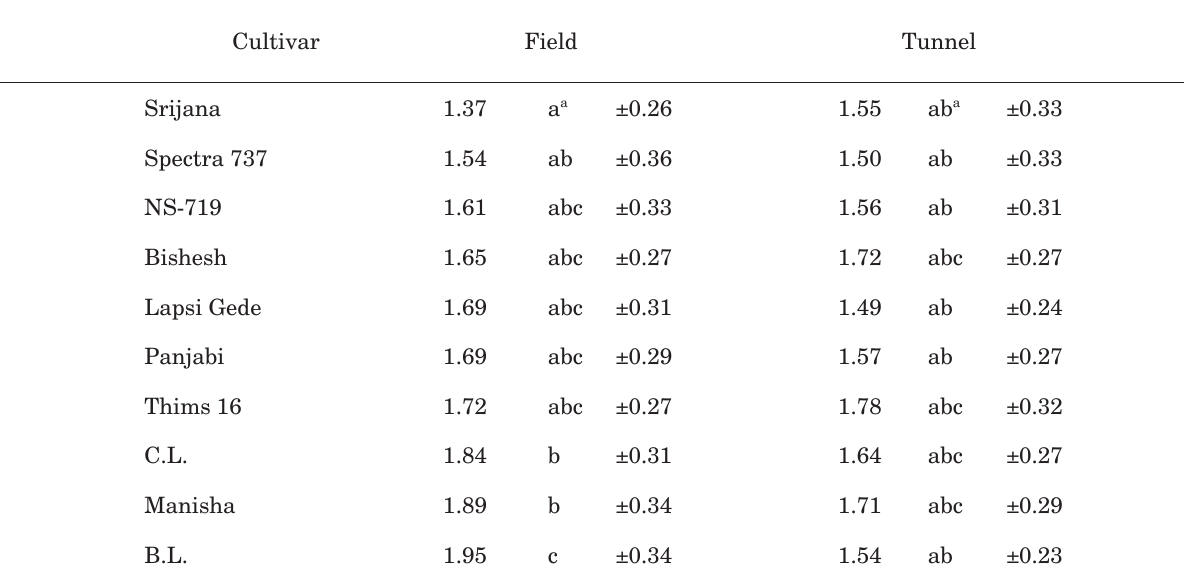
Table 2. Average lesion diameters (mm) formed on tomato leaf in field and in a tunnel 10 days after inoculation caused by Pseudo- monas. syringae pv. tomato (PST